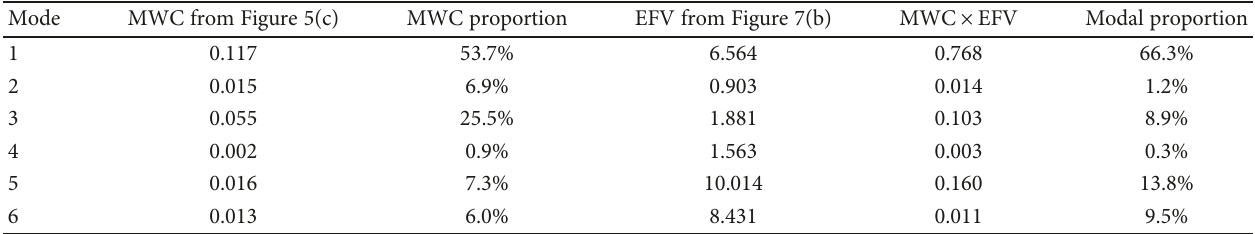
Table 2: MWCs and far fi eld values ( θ = 90 ° and φ = 0 ° ) of the fi rst 6 modes of the ICE-fed antenna at 2.2